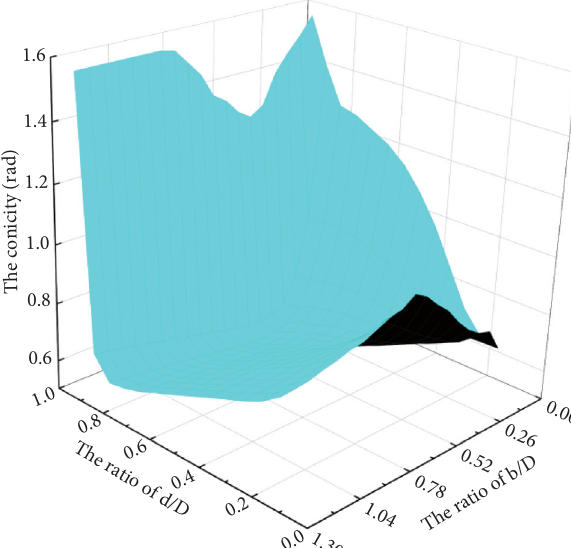
Figure 8: The relations among optimized angle and b / D and d / D